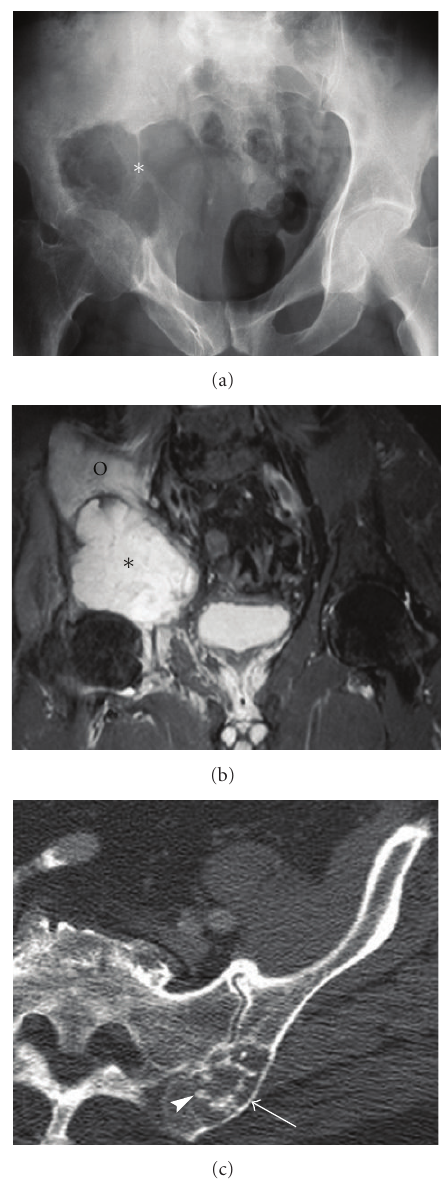
Figure 8: Chondrosarcoma. A 62-year-old male presents with right hip pain, diagnosed with chondrosarcoma. Pelvic radiograph (a) outlines a lytic destructive abnormality centered on the superior acetabular region (asterisk). An associated soft tissue mass is seen extending into the pelvis. The relative lack of calcification of the chondroid matrix would be in keeping with a high-grade chondrosarcoma. Coronal STIR (b) demonstrates the destructive mass (asterisk) as well as associated marrow edema within the right iliac bone (circle) and a small right hip joint e ff usion. Axial CT scan of another patient demonstrates more typical appearances of chondrosarcoma with endosteal scalloping (arrow) and chondroid matrix (arrowhead)